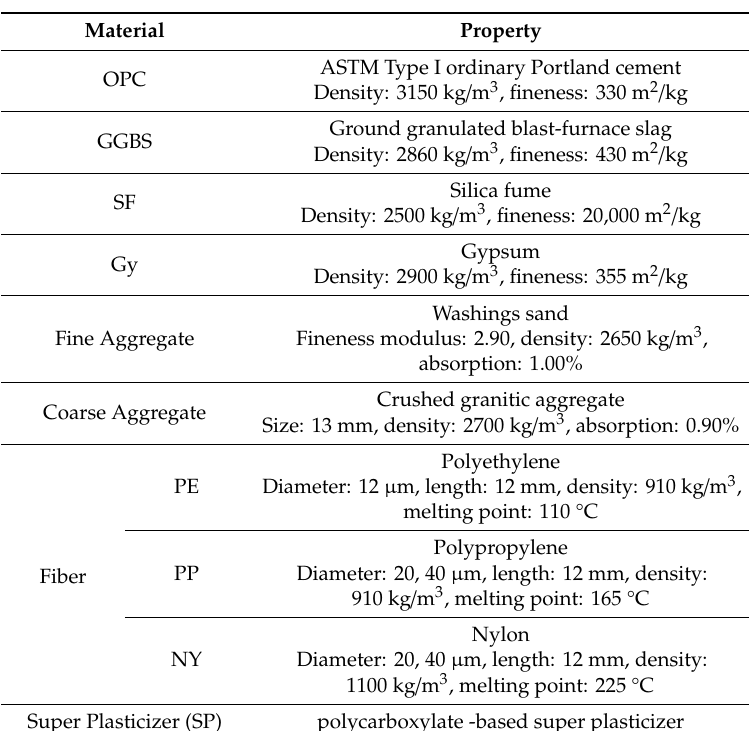
Table 2. Physical properties of the